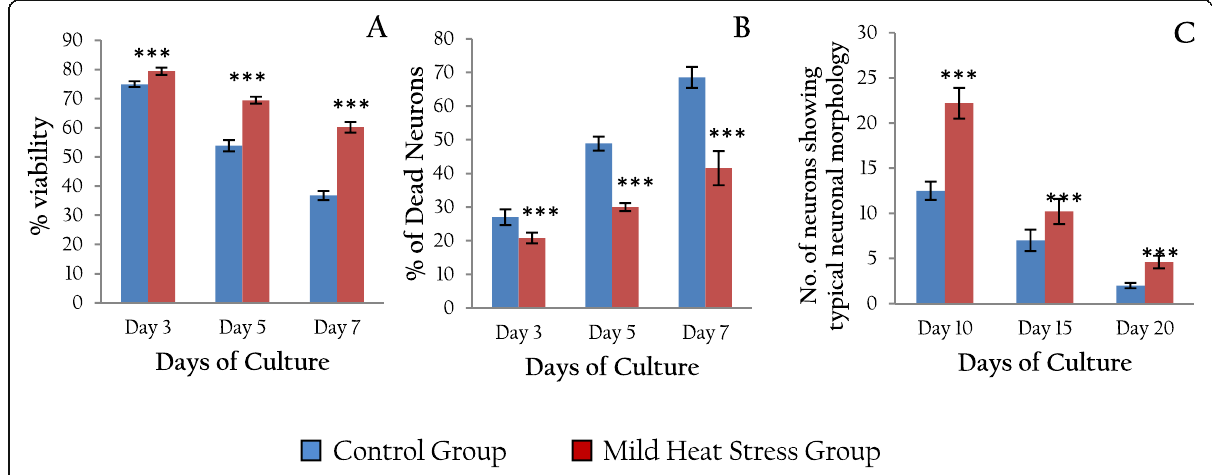
Fig. 2 Effect of mild heat stress on the primary culture of mouse prefrontal cerebrocortical neurons with reference to a : percent viability (stained by calcein – AM and propidium iodide); b : cell death (measured by release of LDH in the culture medium by LDH assay) and c : maintenance of neuronal morphology. Values are arithmetic mean ± SD ( n = 6), *** indicates that the difference is highly significant ( p <